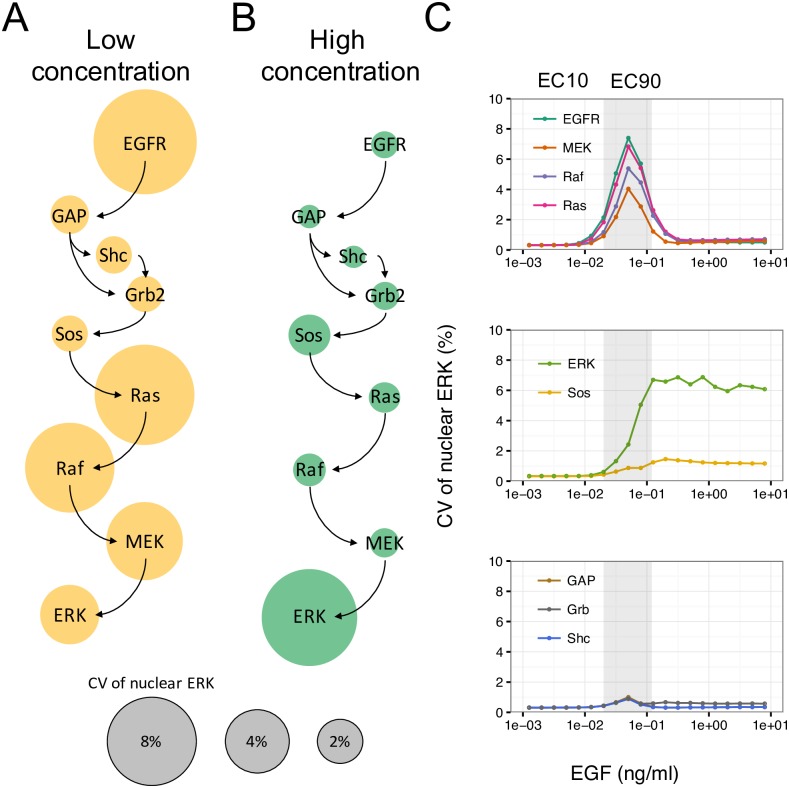
Effects of protein variability of each species on heterogeneity in nuclear ERK.CV of nuclear ERK with changes in protein variability of each species at (A) low (0.05 ng/mL) and (B) high (50 ng/mL) concentrations of EGF. Circle size represents CV of nuclear ERK. (C) CV of nuclear ERK at various concentrations of EGF when changing protein variability of each species. The patterns of CV were classified into three types. CV of 25% was used as protein variability of each species. The gray region represents the area from EC10 (0.02 ng/mL) to EC90 (0.12 ng/mL) calculated from Fig 1D.